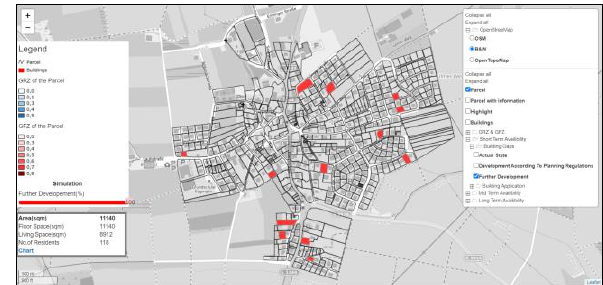
Figure 11 : Building Gaps where 100% of the Land Affected will be Further Developed